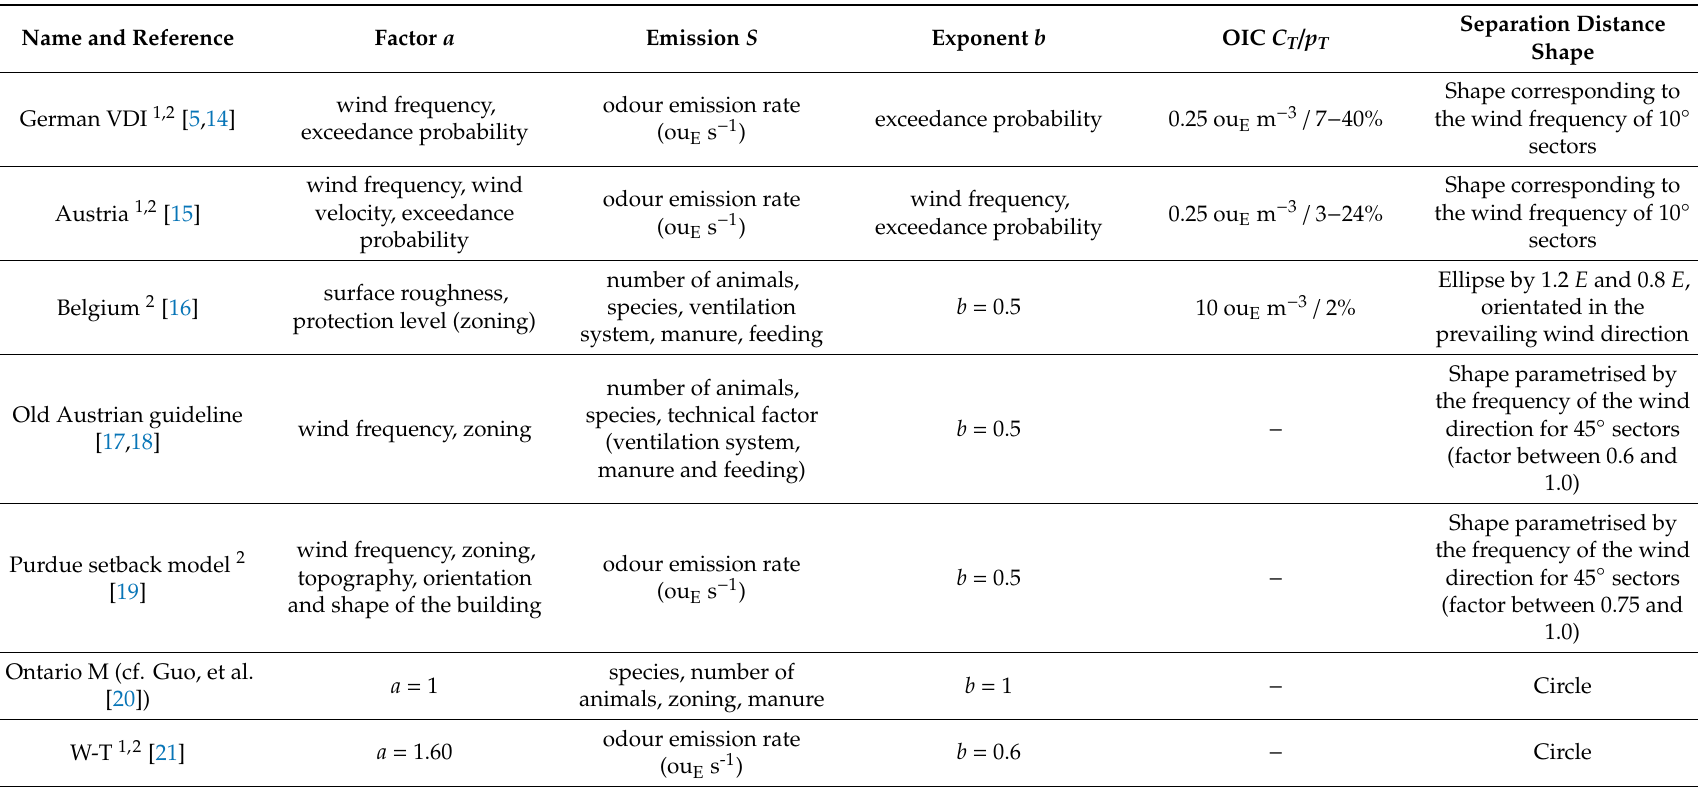
Table 1. List of selected empirical equations (EQs) for the determination of the separation distance E used in di ff erent countries with indication to the predictors (independent variables) of the power function E = a S b with the factor a , the exponent b and the odour emission rate S . The protection level is related to odour